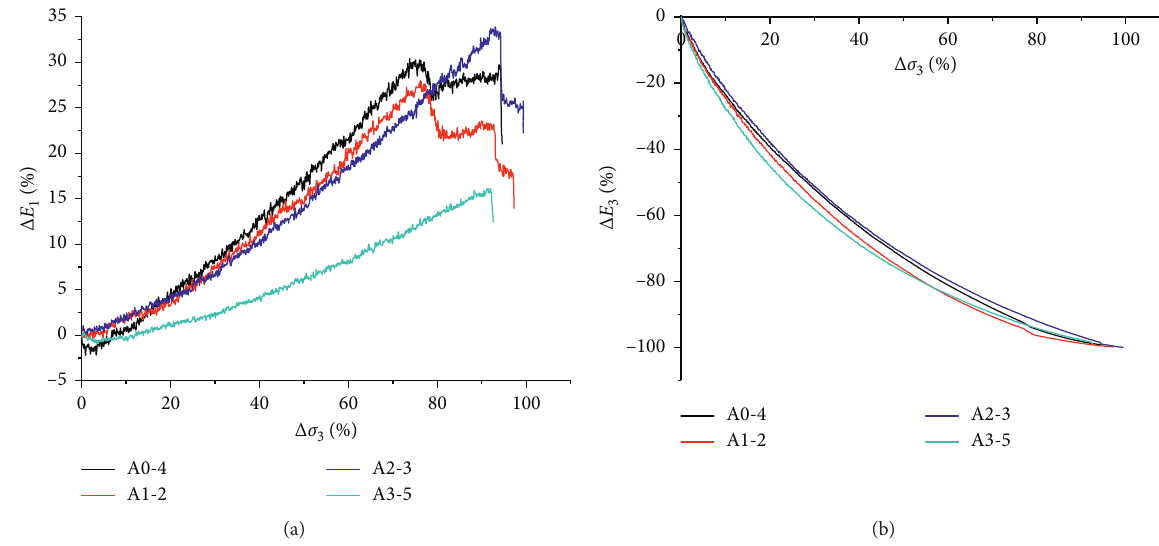
Figure 10: Relationships between the unloading ratios of the confining pressure and the variations of the deformation modulus. (a) Unloading ratios of the confining pressure vs variations of the axial deformation modulus. (b) Unloading ratios of the confining pressure vs variations of the circumferential deformation modulus.